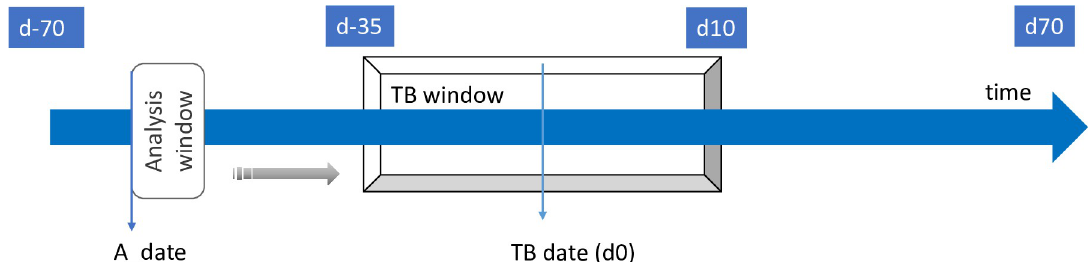
Fig 1. Analysis of the time dependency of the data thanks to the analysis window approach. Analysis window slides along the timeline (blue arrow). The analysis window is classified as TB class, when the A_date (first day of the analysis window) enters the TB window and as CTL class when it is outside the TB window. Control pens are always classified as “CTL”.